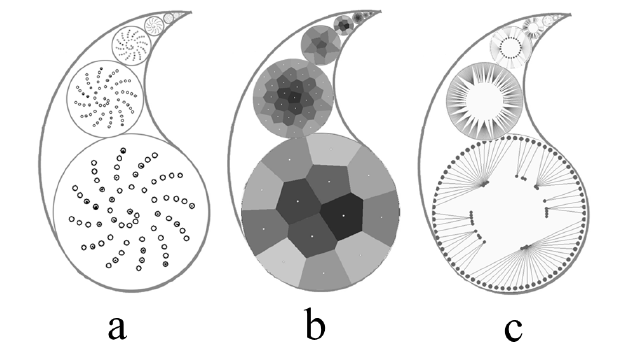
Figure 9. Different design approaches for layouts of descendant nodes: (a) Phyllotactic, (b) Voronoi and (c) Circle.